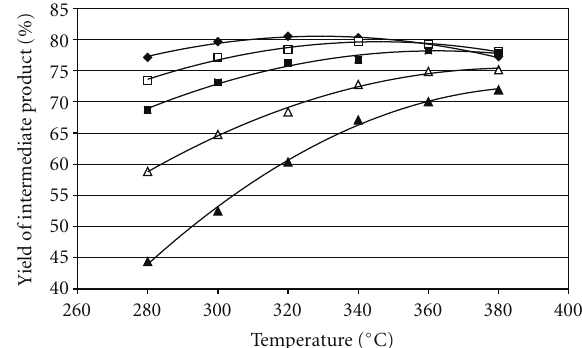
Figure 2: Conversion of triglycerides as a function of the temper- ature and the pressure; where: -80 bar pressure (LHSV = 1.0h − 1 , H 2 /waste lard volume ratio = (cid:3) 600Nm 3 /m 3 ).